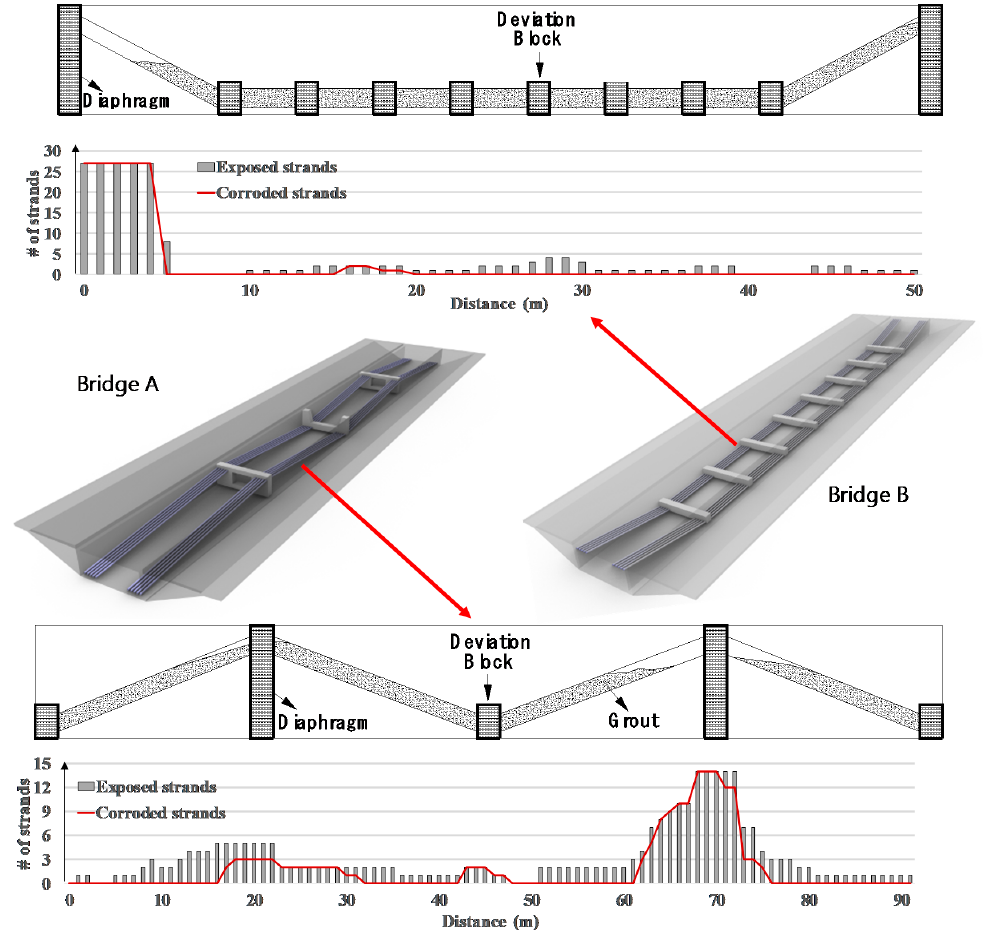
Figure 6. 3D model of tendon profile, state of grout, and corrosion of Bridges A and B.